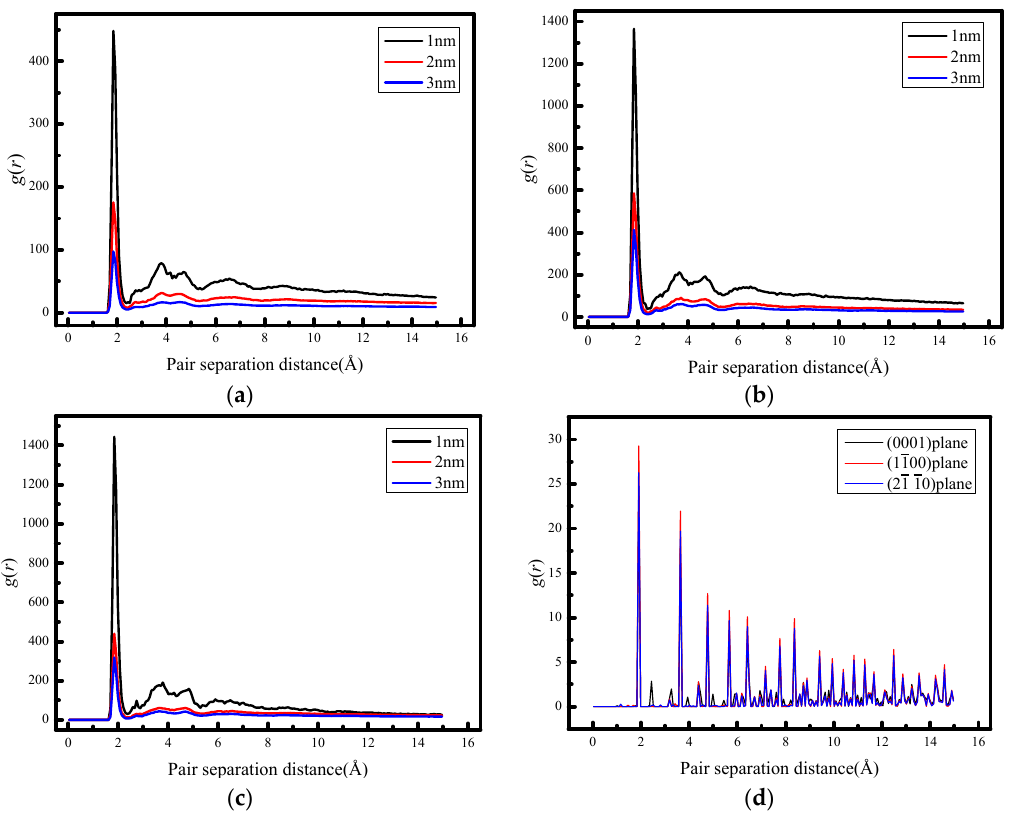
Figure 9. RDF analysis of different crystal faces under different indentation depths. ( a ) (0001) crys-